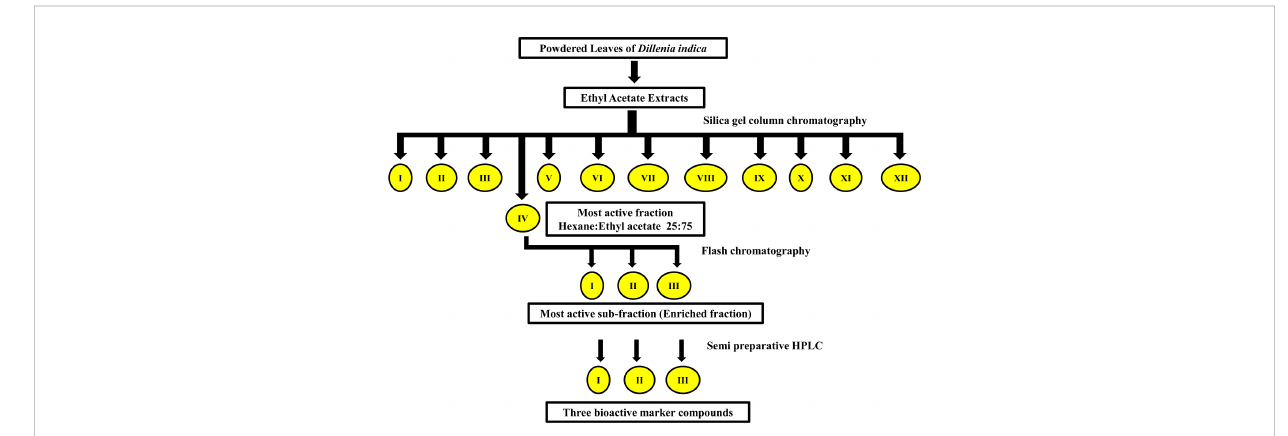
FIGURE 1 Schematic diagram of the isolation of bioactive enriched fraction from ethyl acetate extract of D. indica